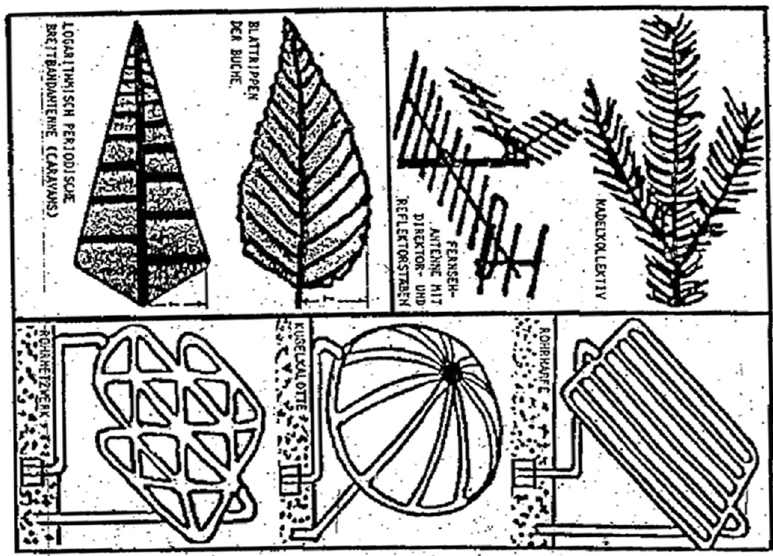
Figure 4: Found footage from artist repository shows the analogy between plant - based structures and